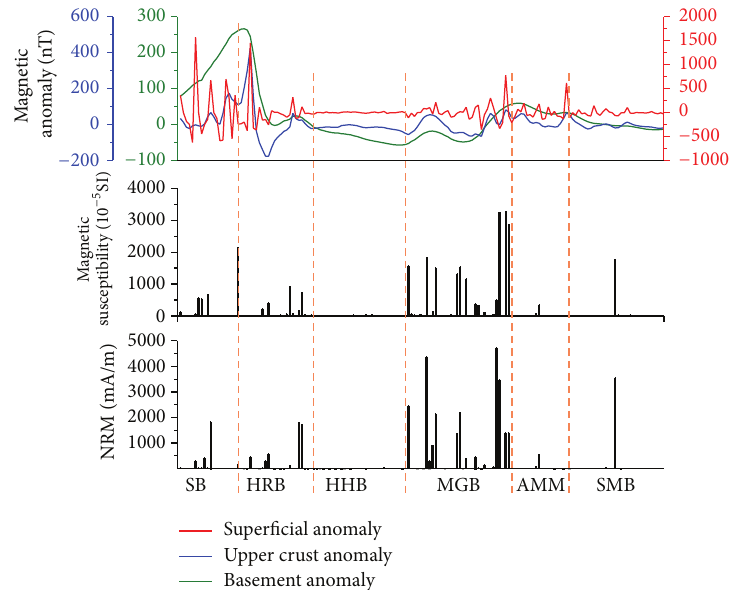
Figure 9: Comparison between different components of lithospheric magnetic anomaly and the NRM and magnetic susceptibility of outcropped rock samples along the profile. Data of the lithospheric magnetic anomalies are compiled from Yuan et al.